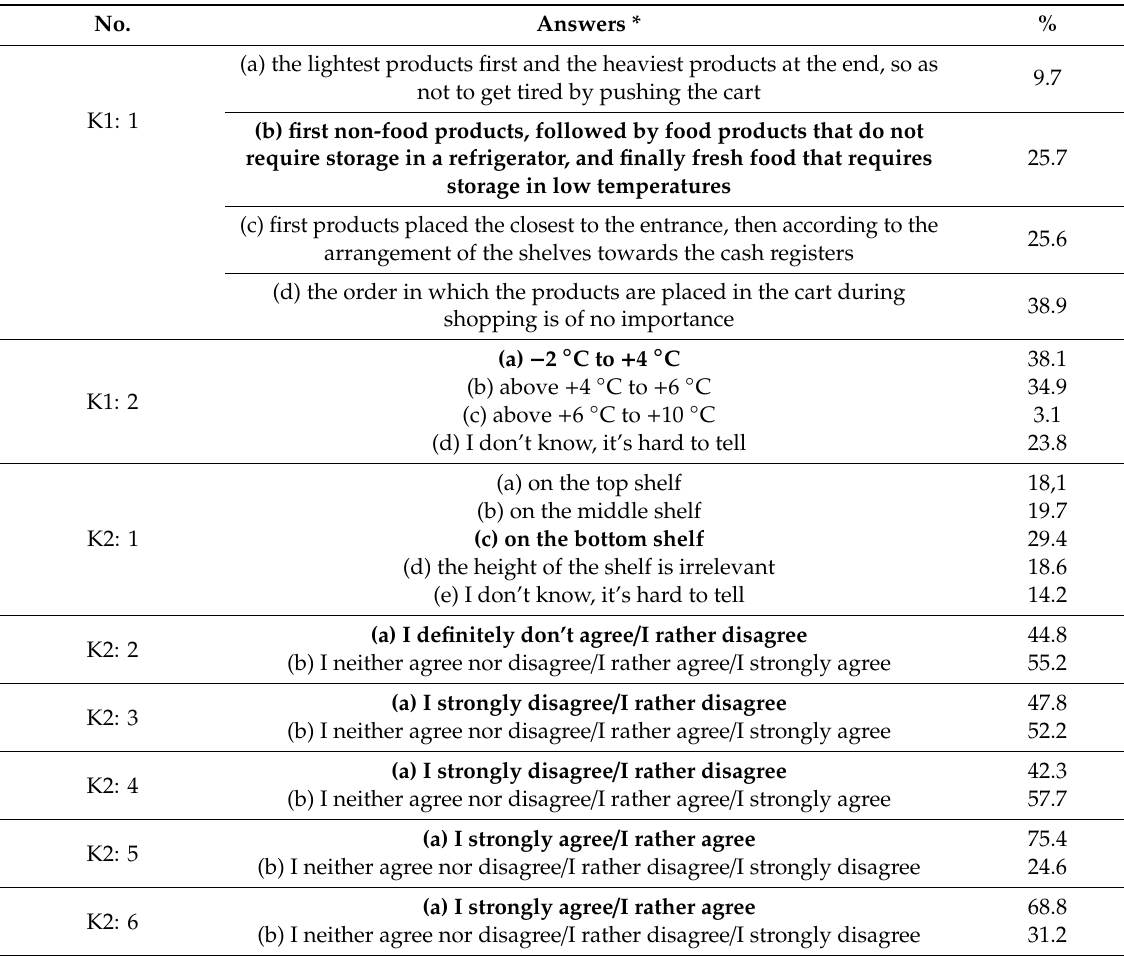
Table 3. Respondents’ food safety knowledge